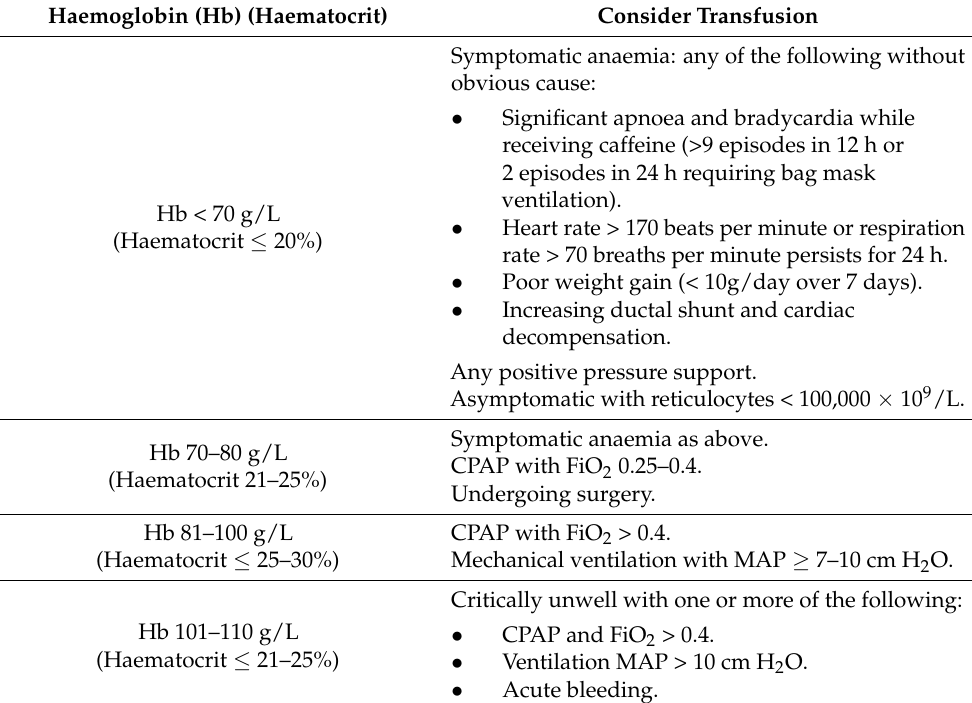
Table A1. Hospital blood transfusion